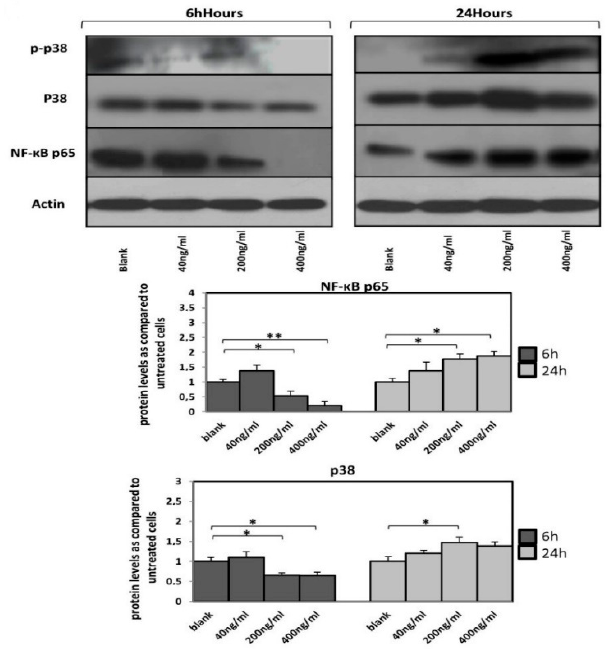
Figure 4. A time-dependent expression of NF- κ B p65, p38 and phospho-p38 protein levels. Reduced NF- κ B p65 protein levels as well as p38 MAP kinase activation in HAECs after incubation with orexin-A for 6 h. Twenty-four hour incubation with orexin-A resulted in increased NF- κ B p65 protein levels as well as p38 MAP kinase activation. A representative blot out of at least three independent experiments is shown at the top; bottom, densitometric analysis. Data are mean ± SEM (fold increase); data are presented as the mean ± SD, ** p < 0.01, * p < 0.05).